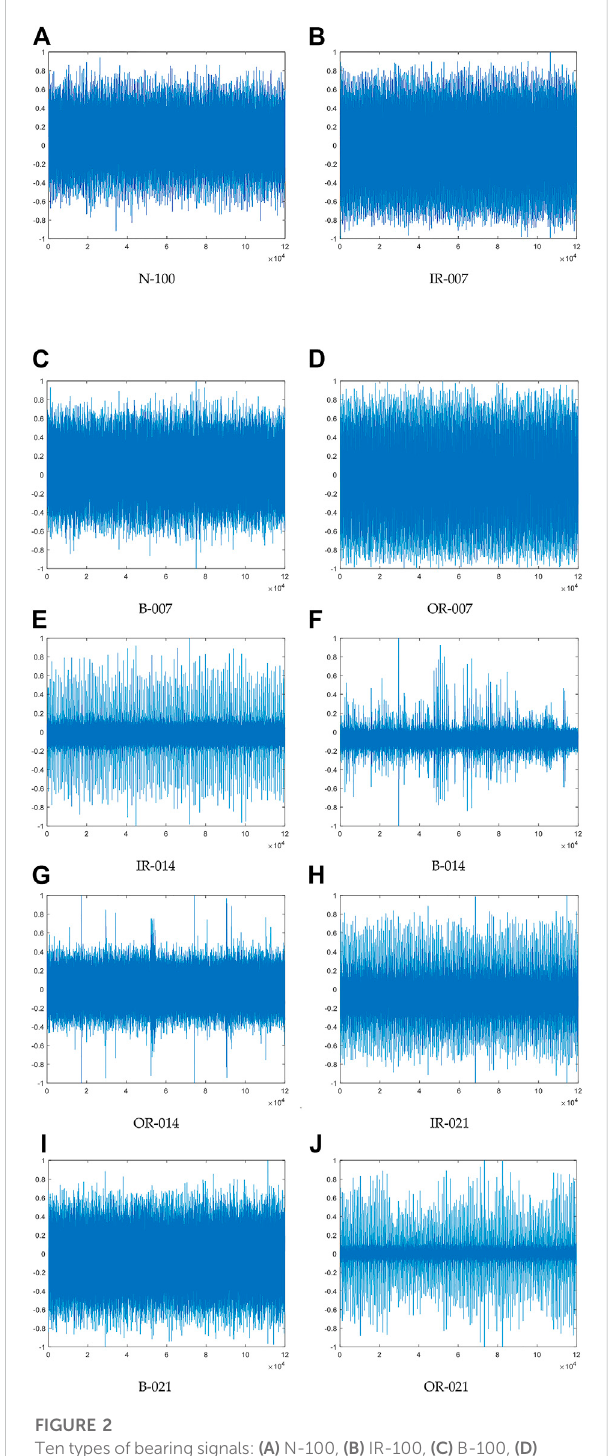
FIGURE 2 Ten types ofbearing signals: (A) N-100, (B) IR-100, (C) B-100, (D) OR-100, (E) IR-014, (F) B-014, (G) OR-014, (H) IR-021, (I) B-021, (J)